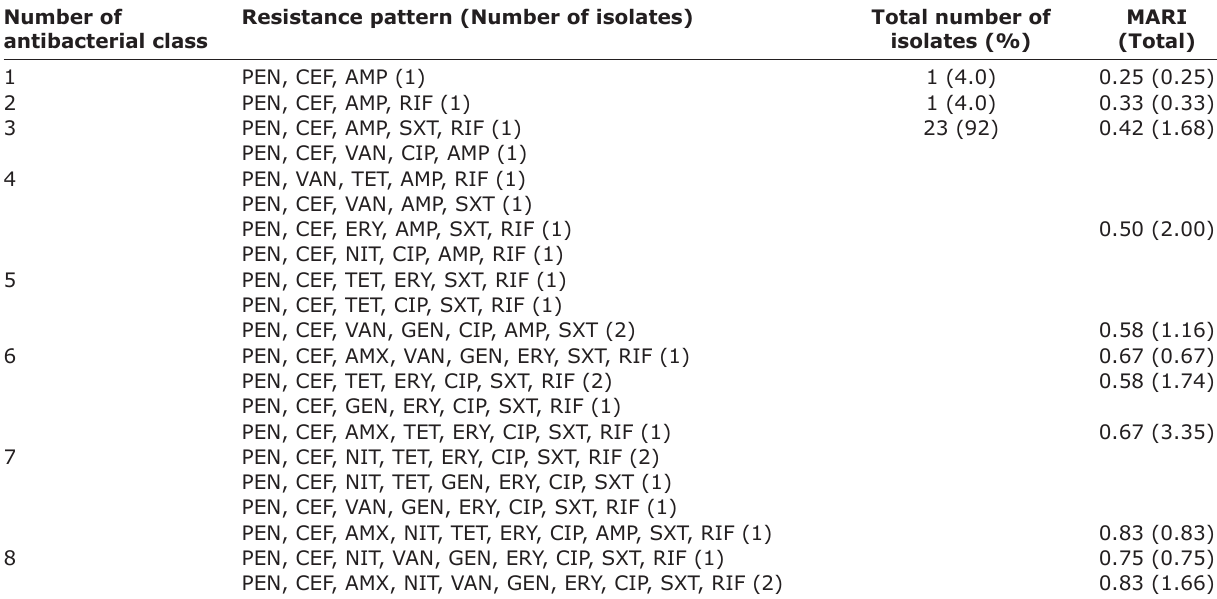
Table-4: Multiple antibacterial resistance patterns and indices of 25 Listeria isolates from raw chicken meats marketed in Enugu State Southeast Nigeria. Number of antibacterial